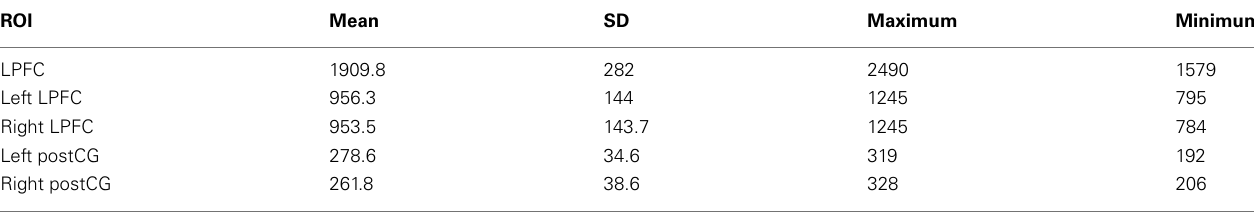
Table 1 | Number of voxels in each